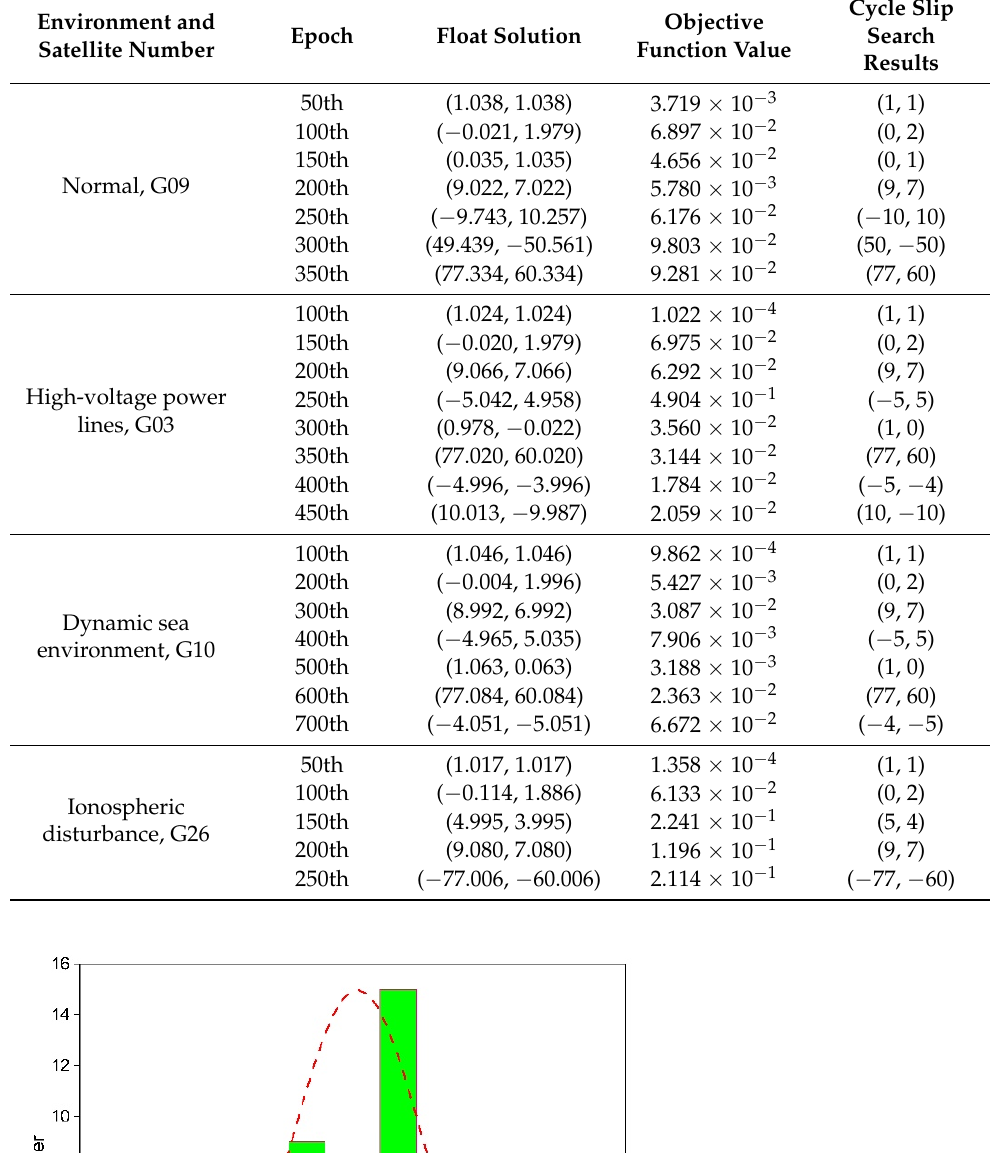
Table 2. Cycle slip repair results.